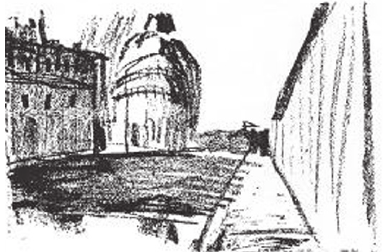
fig. 2. Piazza dei Miracoli in Pisa. from le Corbusier 1960,